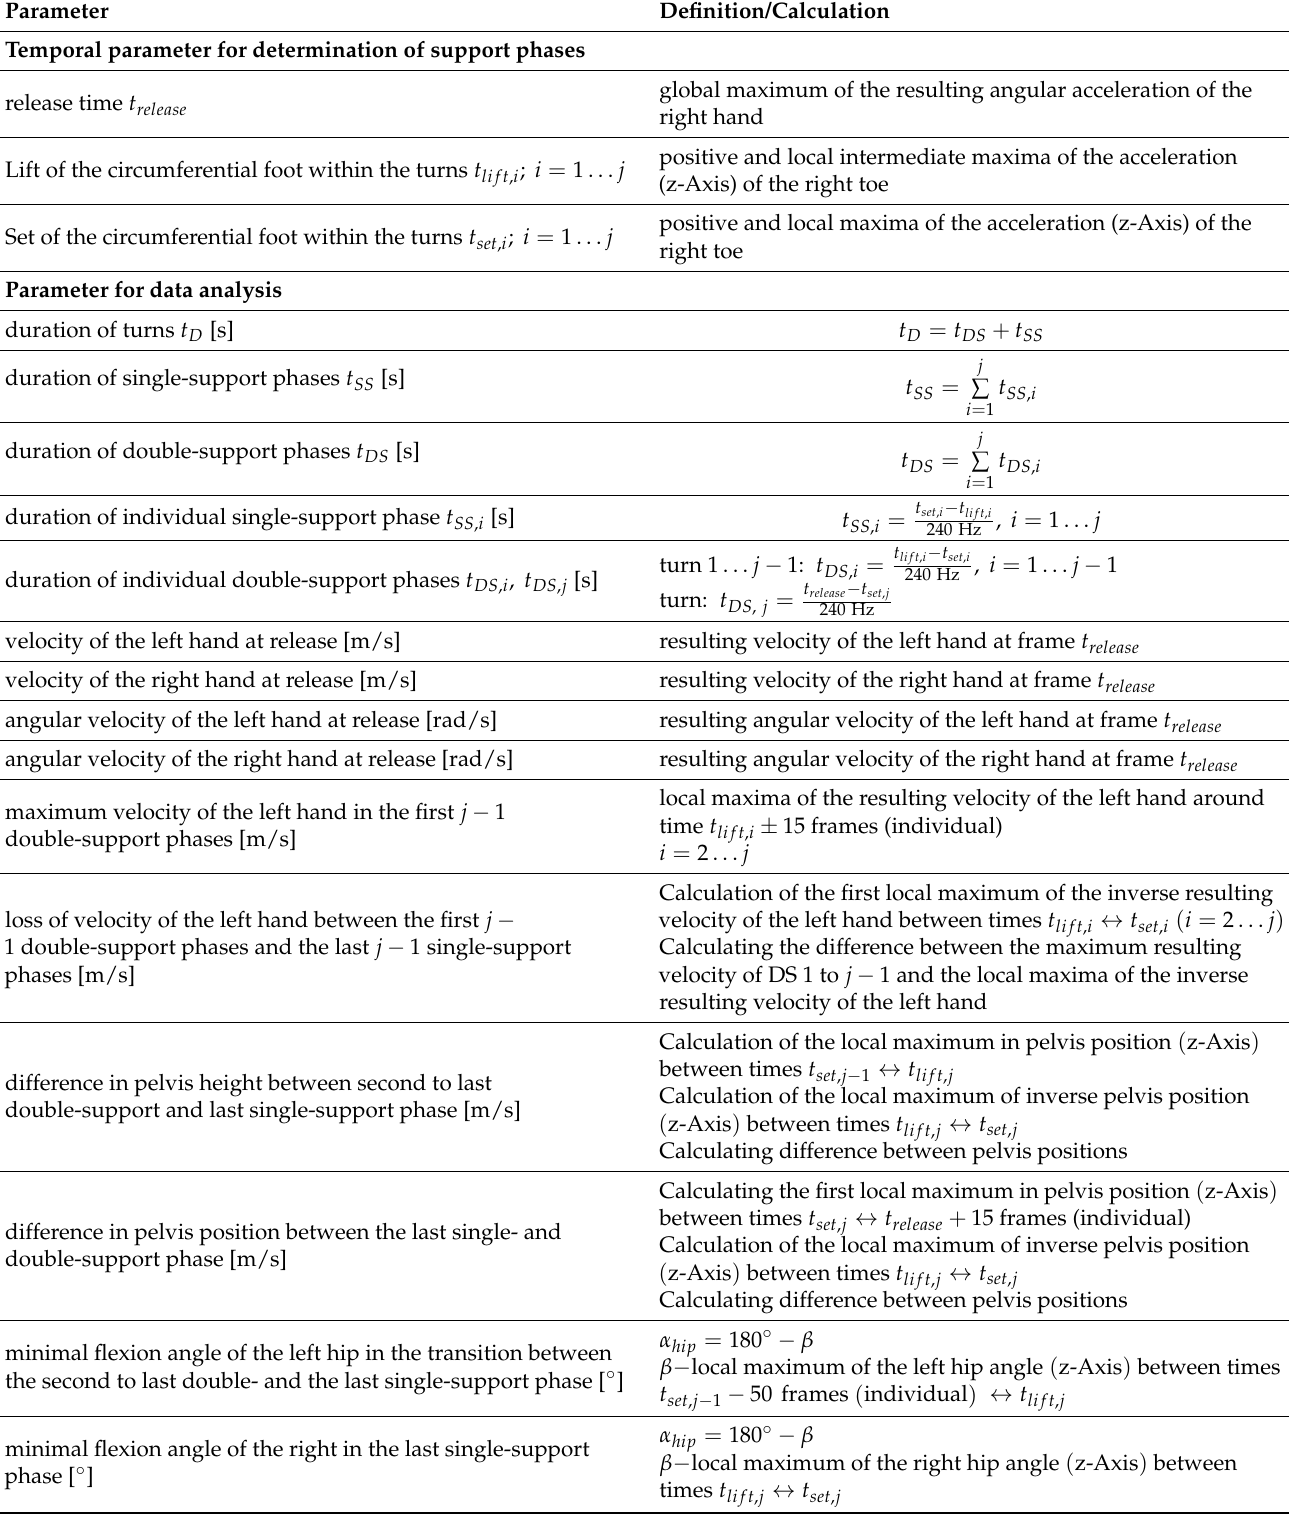
Table A1. List and definitions of parameters used for determination of double- and